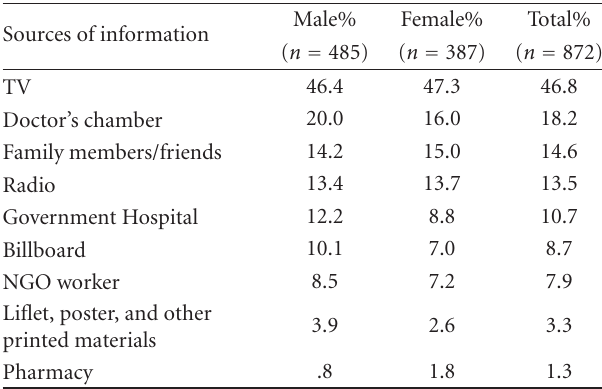
Table 2: Distribution according to sex and sources of information about